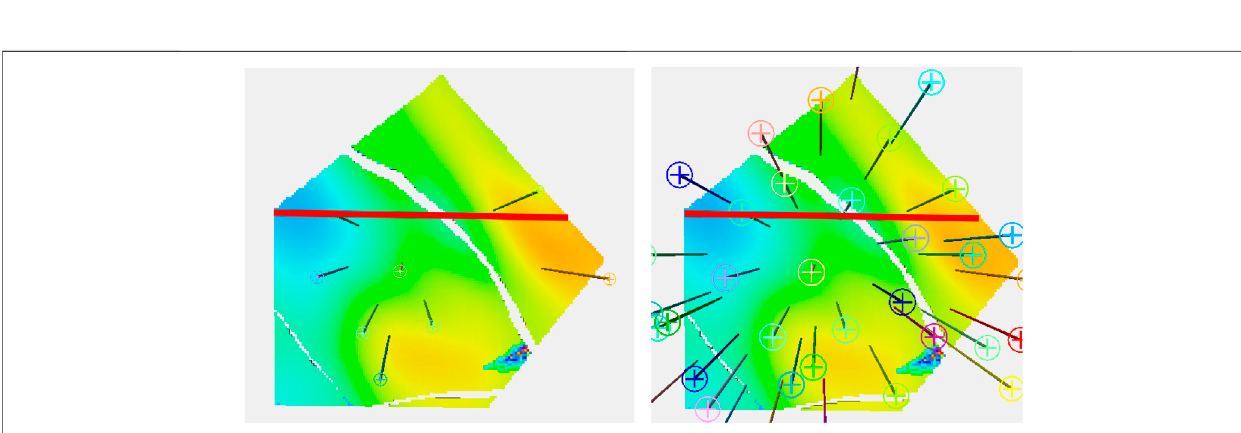
location. The thick red line on the images represent the location